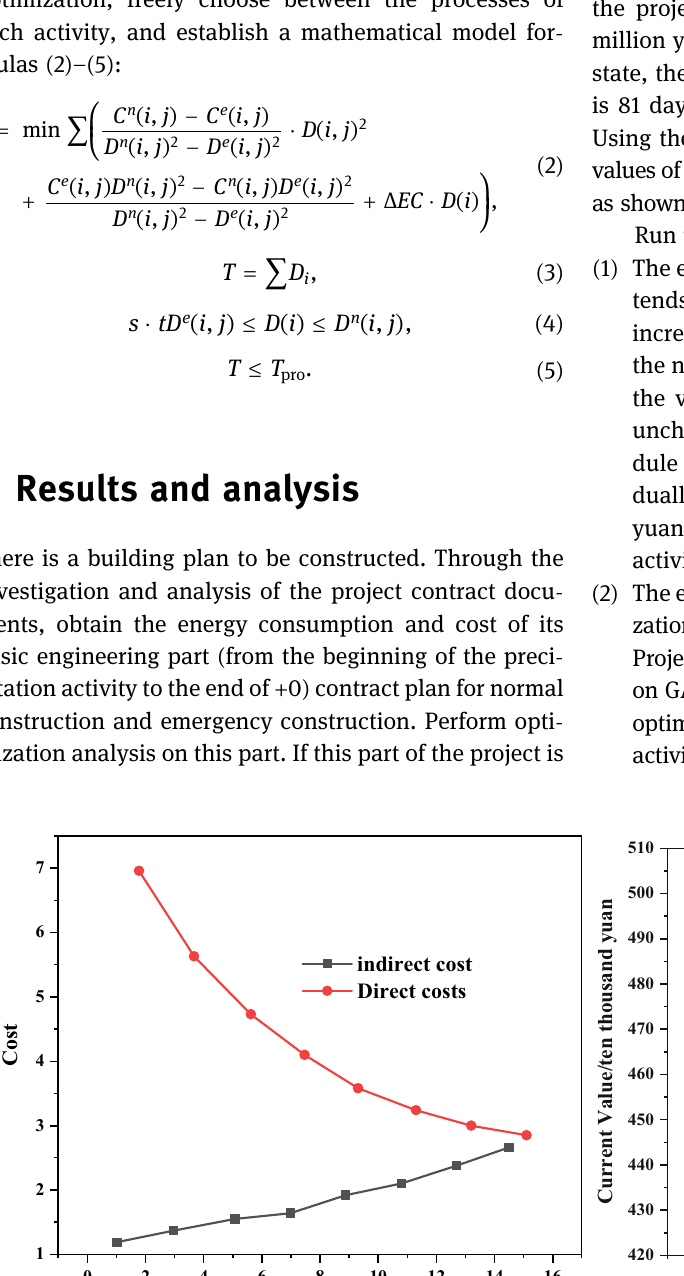
Figure 4: The relationship curve between time and cost.